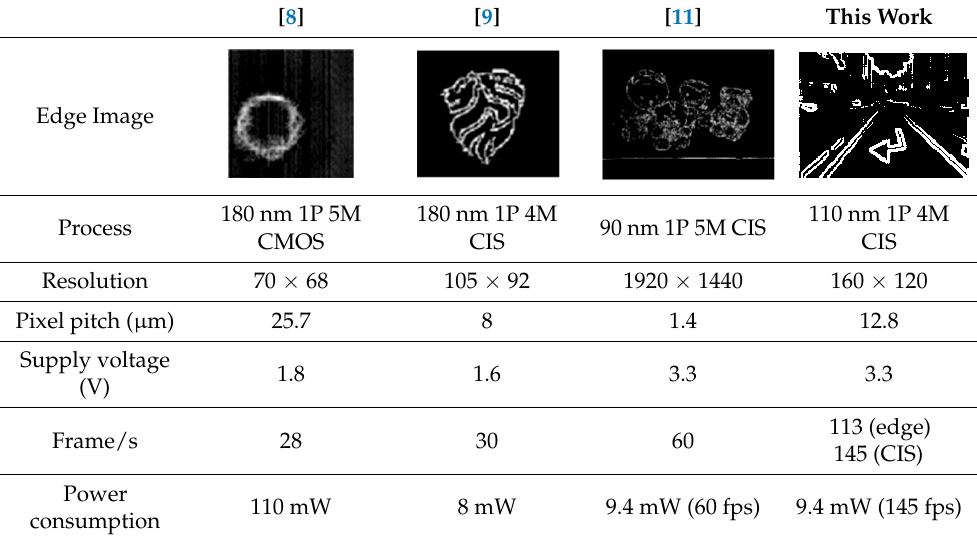
Table 6. Comparison of performance characteristics of the proposed CIS and other circuits.